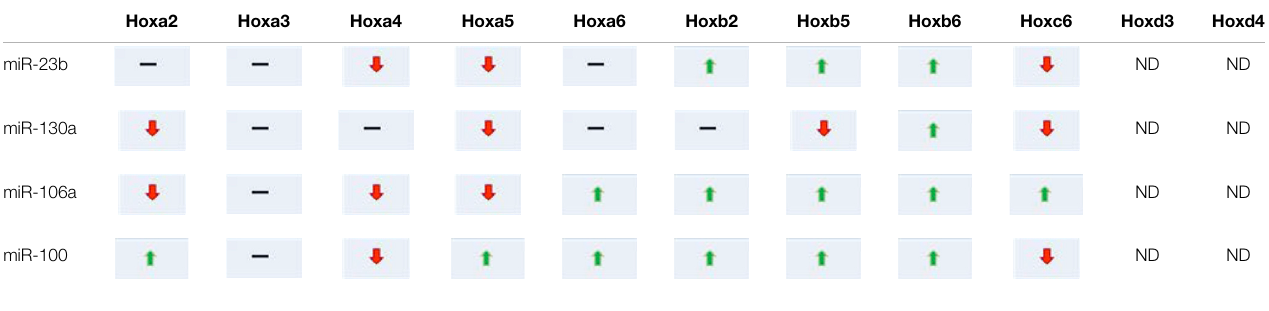
TABLE 3 | Hox genes modulated by microRNAs in the sinus venosus at stage HH15. Hoxa2 Hoxa3